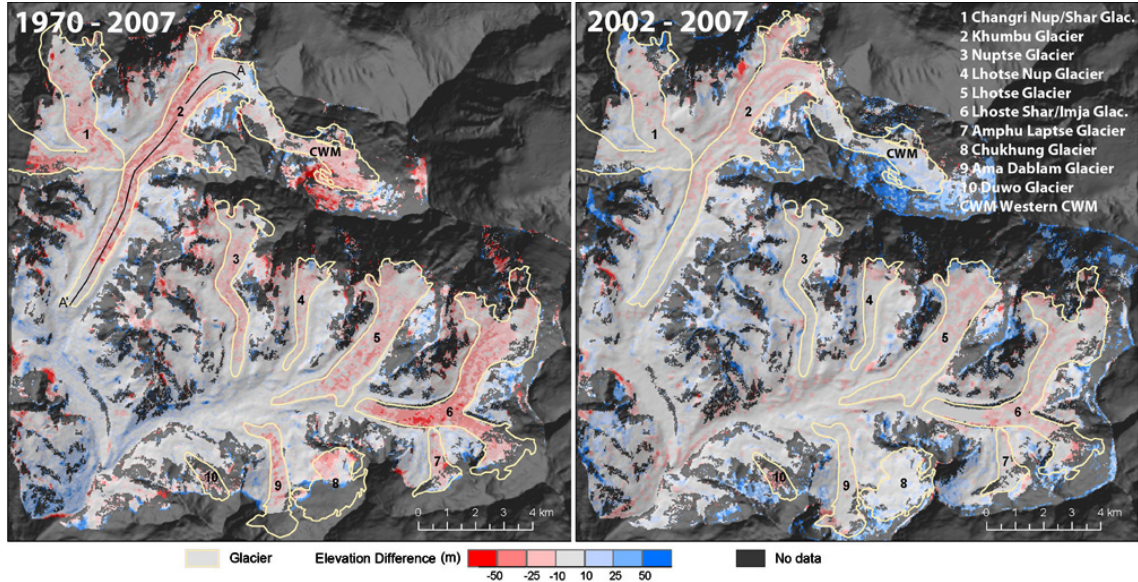
Fig. 3. DTM differences of the study area 1970–2007 and